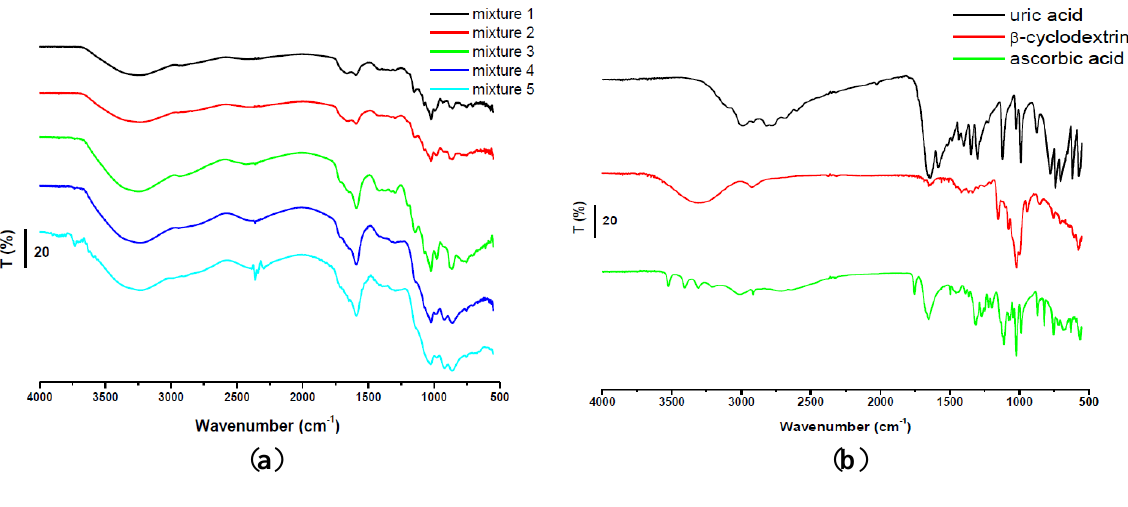
Figure 5. ( a ) FTIR spectra for the five mixtures: (mixture 1) β-CD: UA: AA = 1:1:1, (mixture 2) β-CD: UA: AA = 1:1:2, (mixture 3) β-CD: UA: AA = 1:1:4, (mixture 4) β-CD: